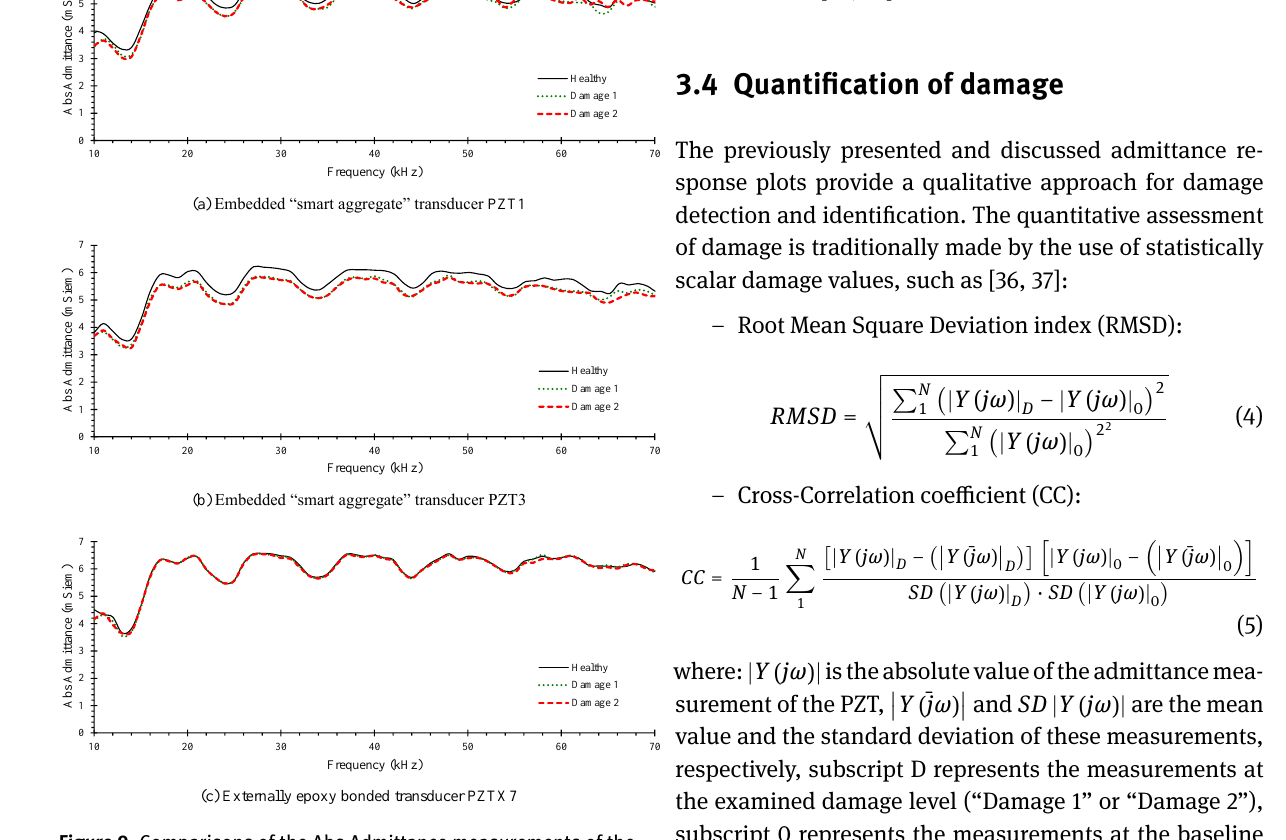
ducers PZT1, PZT3 with respect to the epoxy bonded trans- ducer PZTX7.